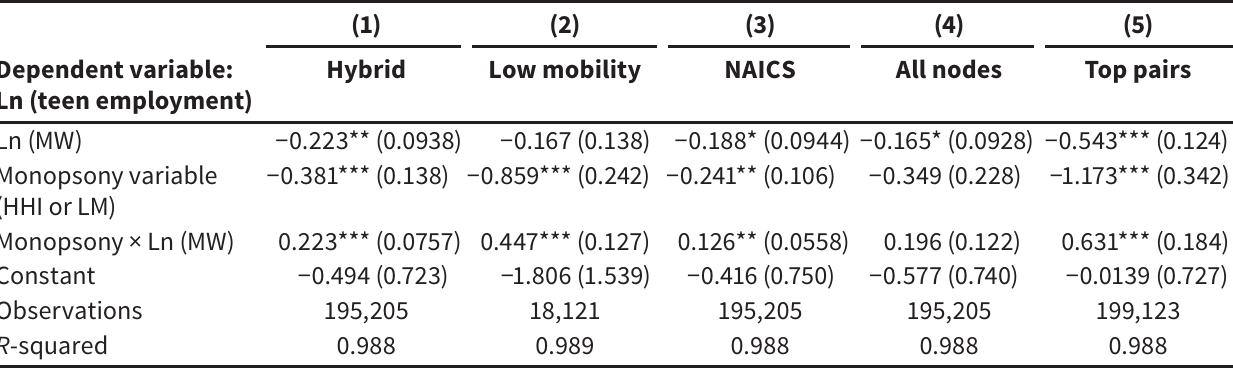
Effects of the log of the MW interacted with the HHI and low mobility on the log of teenage employment (HHI calculated only for teenage